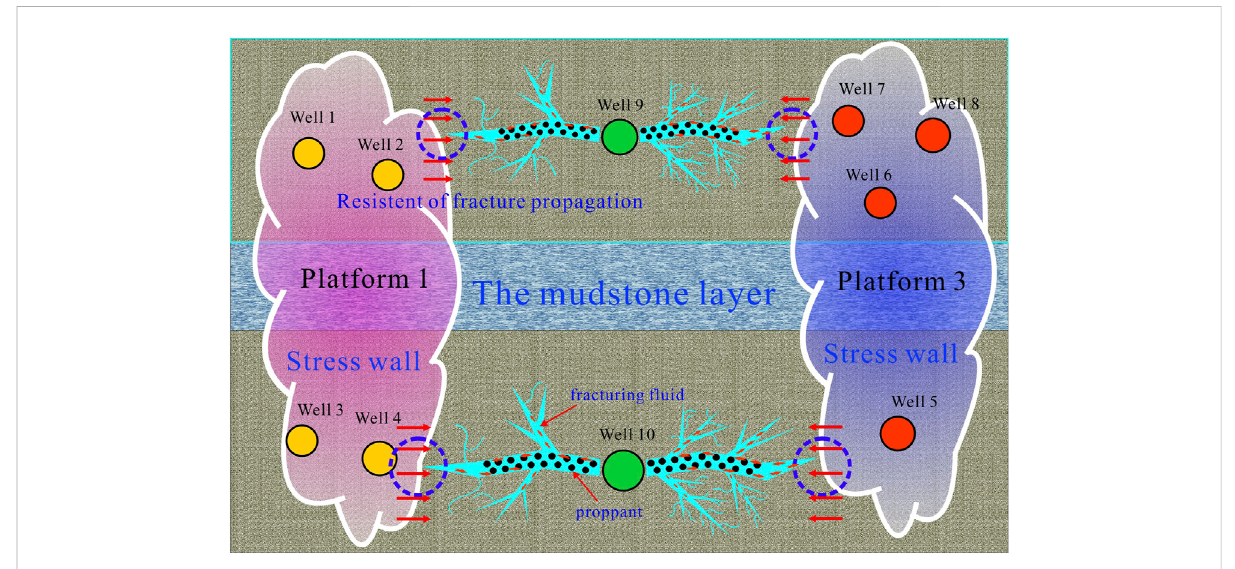
FIGURE 4 Diagram of the formation mechanism of proactive stress interference in a complex fracture